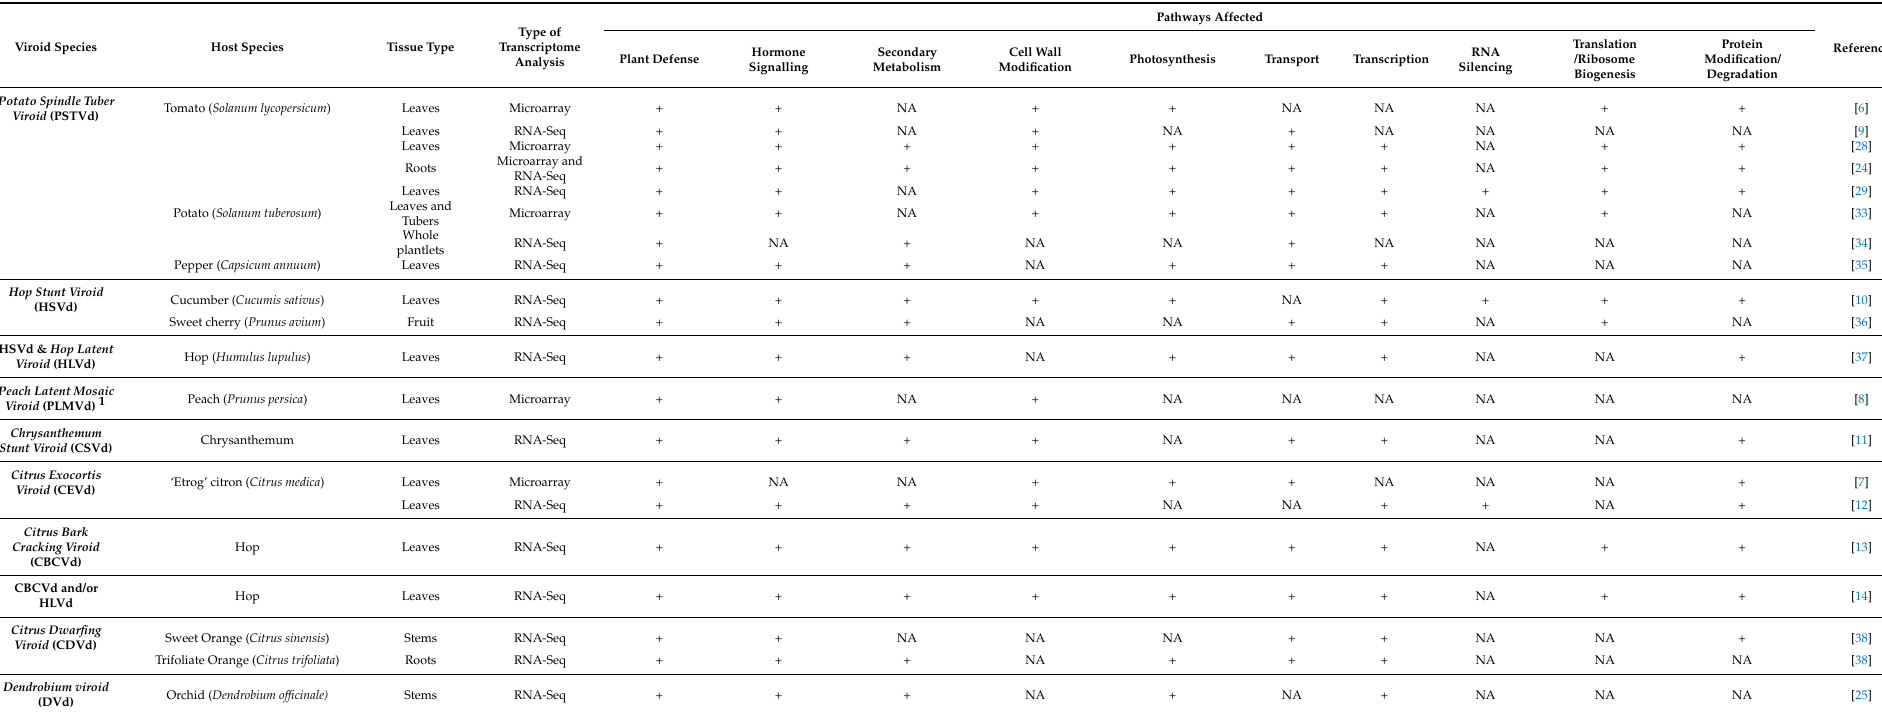
Table 1. Molecular pathways with significant changes in gene expression after viroid infection of different hosts, as revealed by global transcriptome studies. Pathways with altered expression are indicated by + symbol, while pathways not mentioned to be altered in transcription are indicated by